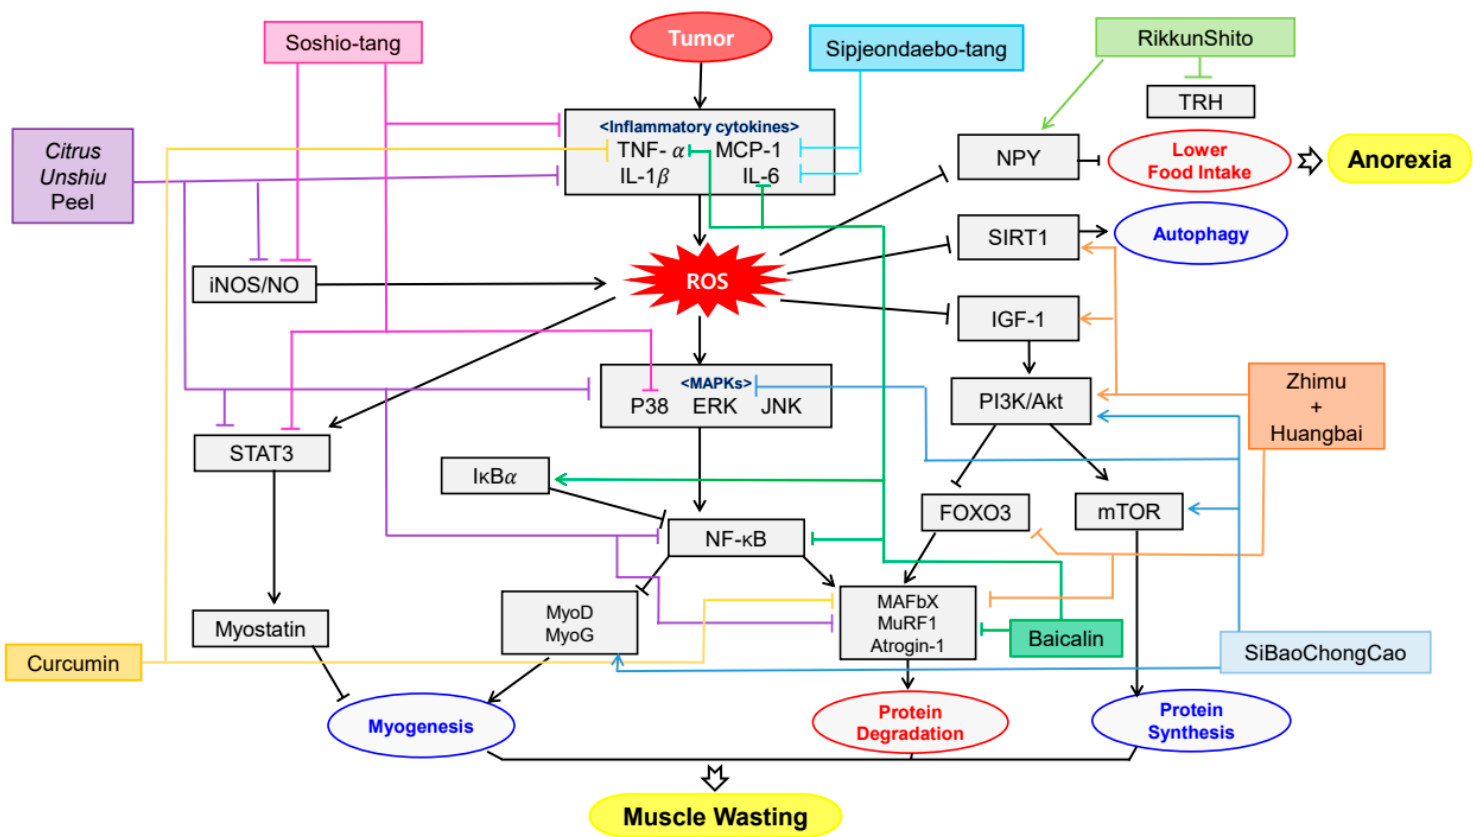
Figure 3. Schematic diagram of anti-inflammatory & antioxidant mechanisms of plant-derived drugs in cachexia.